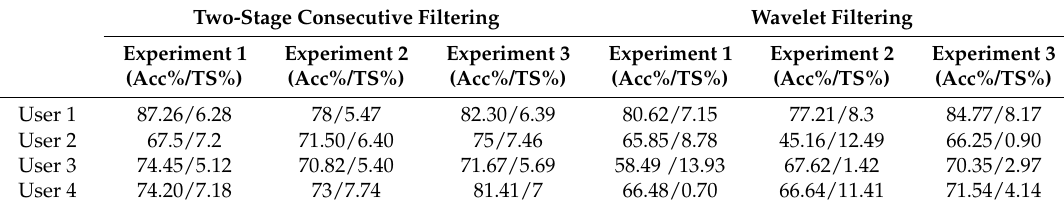
Table 7. Classification performance obtained from IMU and 3-axial acceleration sensors: filtering comparison.